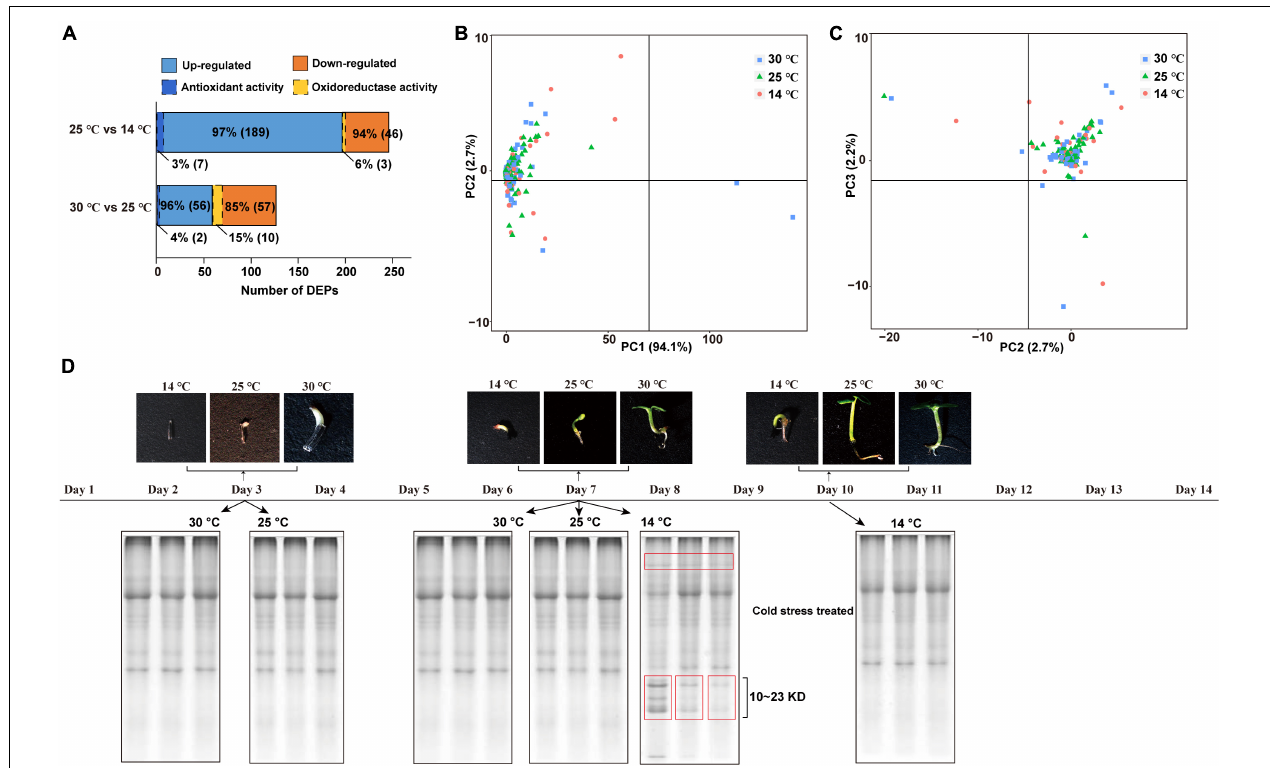
FIGURE 4 | Proteins expression profiles of M. micrantha germs. (A) Numbers of differentially regulated DEPs, and number of antioxidant/oxidoreductase-related DEPs identified from the comparison groups of 25 ◦ C and 14 ◦ C, 30 ◦ C and 25 ◦ C. (B,C) Principal component analysis of proteins identified from germs germinated at 14 ◦ C, 25 ◦ C, and 30 ◦ C. A PC1- × -PC2 plan (B) ; a PC2- × -PC3 plan (C) . (D) SDS-PAGE analysis of soluble proteins isolated from 3 rd and 7 th days at 25 ◦ C and 30 ◦ C, and 7 th and 10 th days at 14 ◦